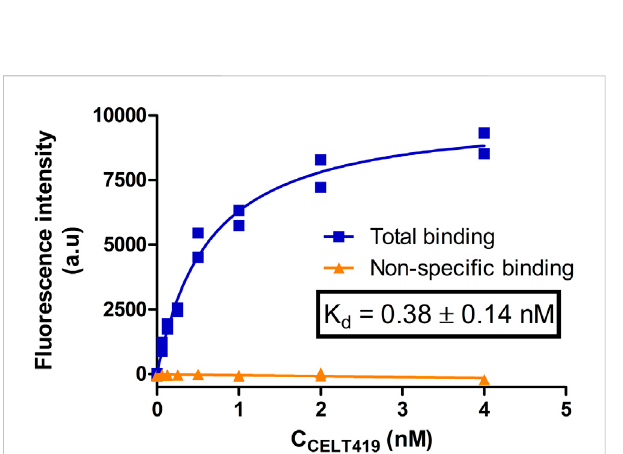
FIGURE 7 Saturation binding of CELT-419 binding to D 3 receptors on live HEK293-D3R cells. The HEK293-D3R cells (20,000 cells per well) wereincubatedwithCELT-419(twofoldserialdilutionsupto4 nM)for 4.3 h. Non-speci fi c binding (orange triangles) was measured in the presence of 10 μ M Spiperone. The background-corrected fl uorescence intensities of cells were determined with the cell detection and image quanti fi cation software as described in Materials and methods and are presented as individual replicates from a representative experiment of three independent experiments performed in duplicates. Every point corresponds to the difference between the average pixel intensity of a cell and the average pixel intensityofthebackground.Theaveragepixelintensitiesofeachpoint were calculated from four images from different fi elds of view obtained fromasingle well.The calculatedK d valueisgivenas mean± SEM of three independent experiments. bound fl uorescence ligand, the binding af fi nity of CELT-419 to live HEK293-D3R cells can be determined . The K d ± SEM of 0.38 ± 0.14 nM determined from the saturation binding curve (Figure 7; Supplementary Figure S3) is in good agreement with the af fi nity